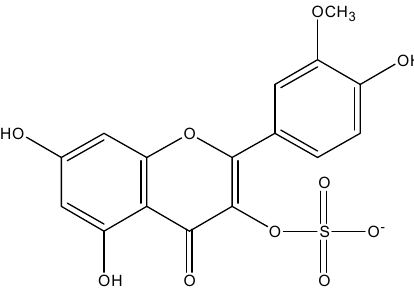
Figure 3. Structure of Persicarin, the first sulphated flavonoid reported.